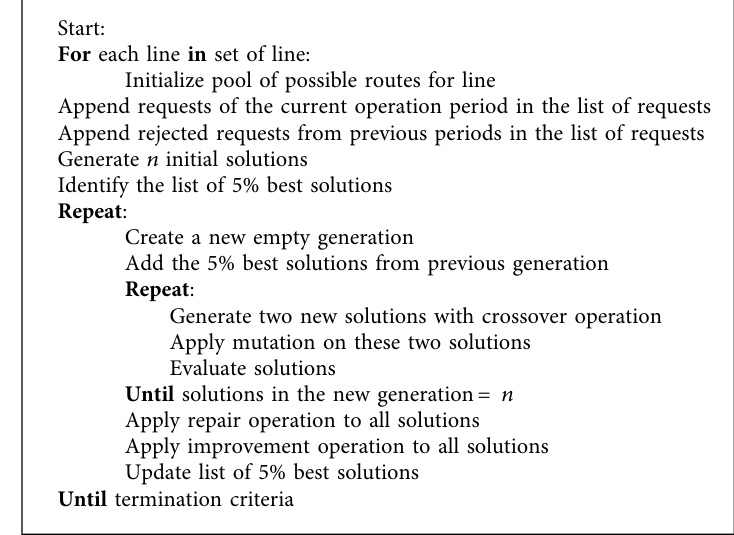
A LGORITHM 1: MA full algorithm